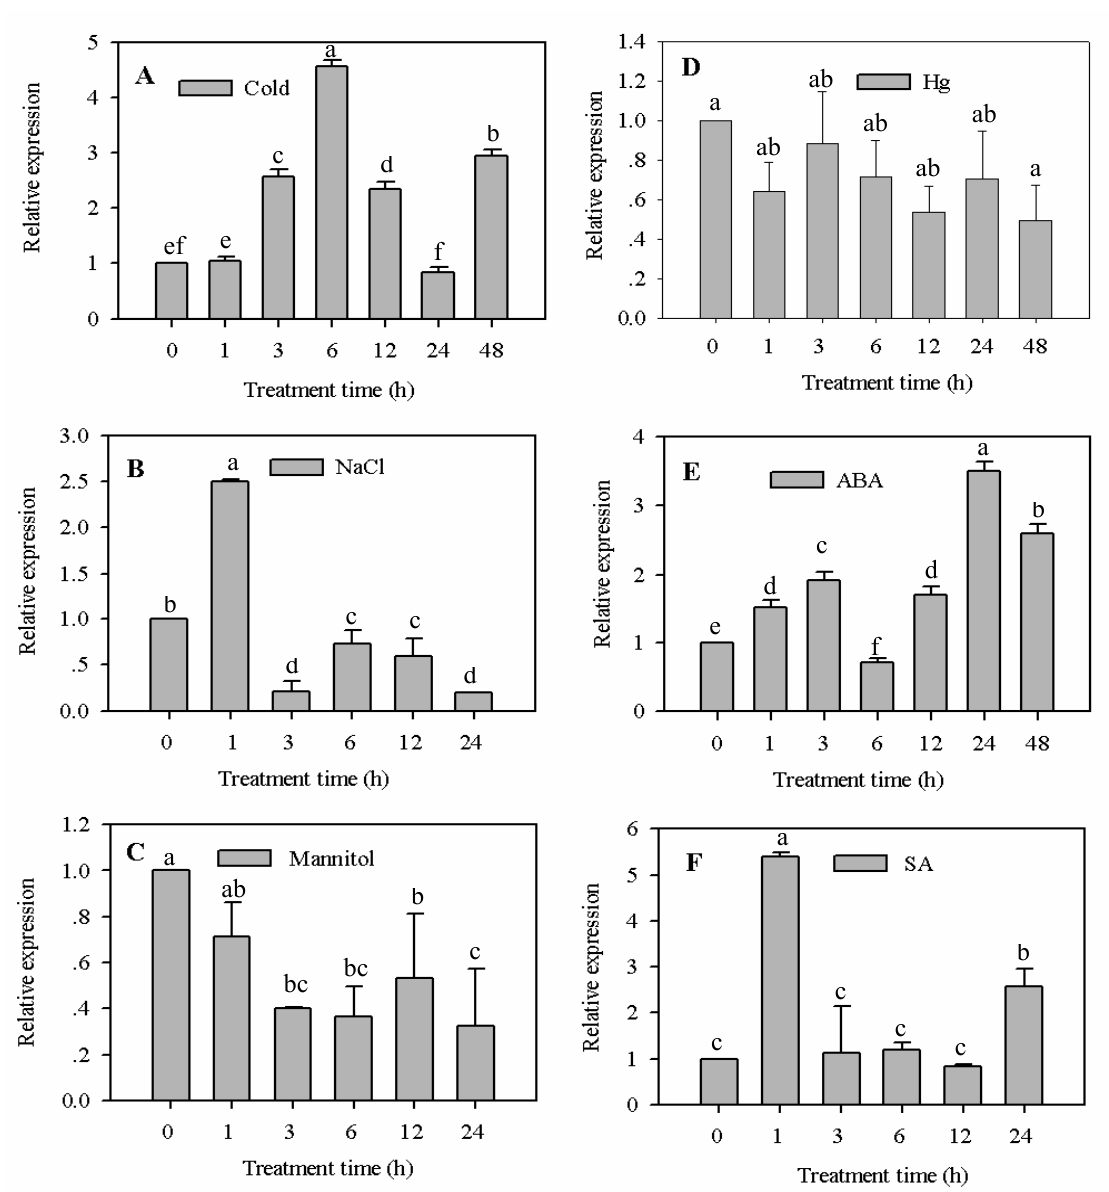
Figure 4. Real-time RT-PCR analysis of relative CaF-box expression levels in the leaves of pepper plants after abiotic stress and plant hormone treatments. ( A ) Cold stress; ( B ) Salt stress; ( C ) Osmotic stress; ( D ) Heavy metal stress; ( E ) ABA treatment; ( F ) SA treatment. Error bars represent the mean ± SD of three independent biological replicates. Different letters indicate significant differences ( p <